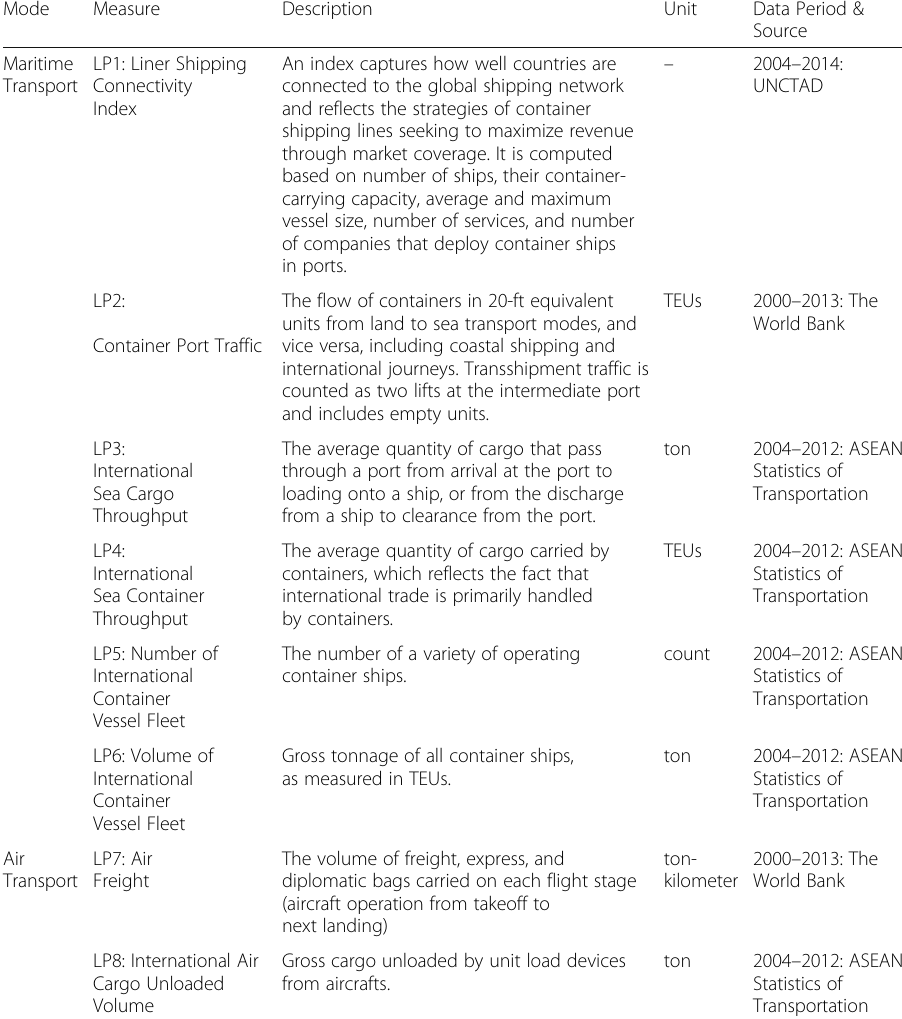
Table 1 Definition and Data Description of Measurements for Transport logistics Performance Mode Measure Description Unit Data Period &